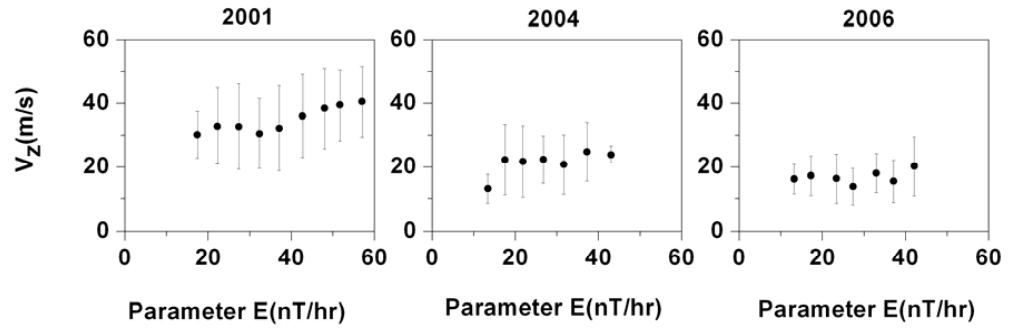
Figure 4(b): Plot of the average V z , with the standard deviation, against the ‘parameter E’, taken in intervals of 5 nT/hr, for the solar maximum, moderate and minimum years of 2001, 2004 and 2006.